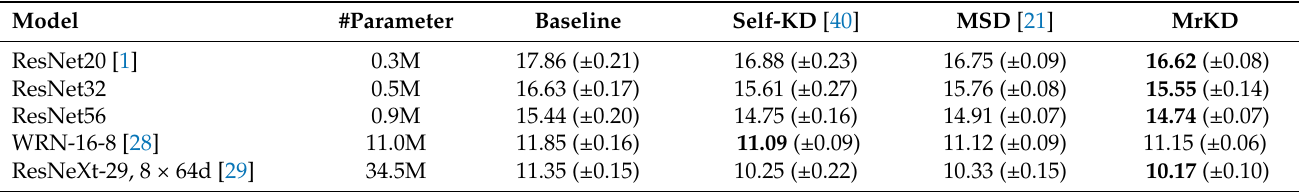
Figure 10. Samples from the CINIC-10 dataset. Upper : inherit from the CIFAR-10 dataset. Lower : extended from ImageNet dataset. The labels from left to right: plane, ship, bird, dog, car, cat, horse, and deer. Table 5. Test error rate comparison on the CINIC-10 [27] dataset (mean( ± standard deviation), in %).